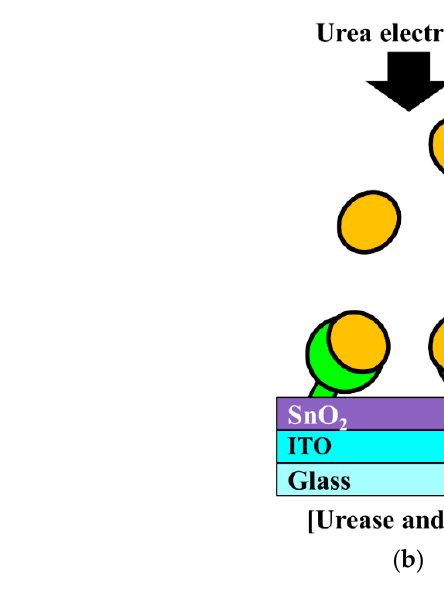
Figure 1. Schematic illustration of ( a ) the interaction between the SnO 2 membrane and urea and ( b ) the interaction between urease and